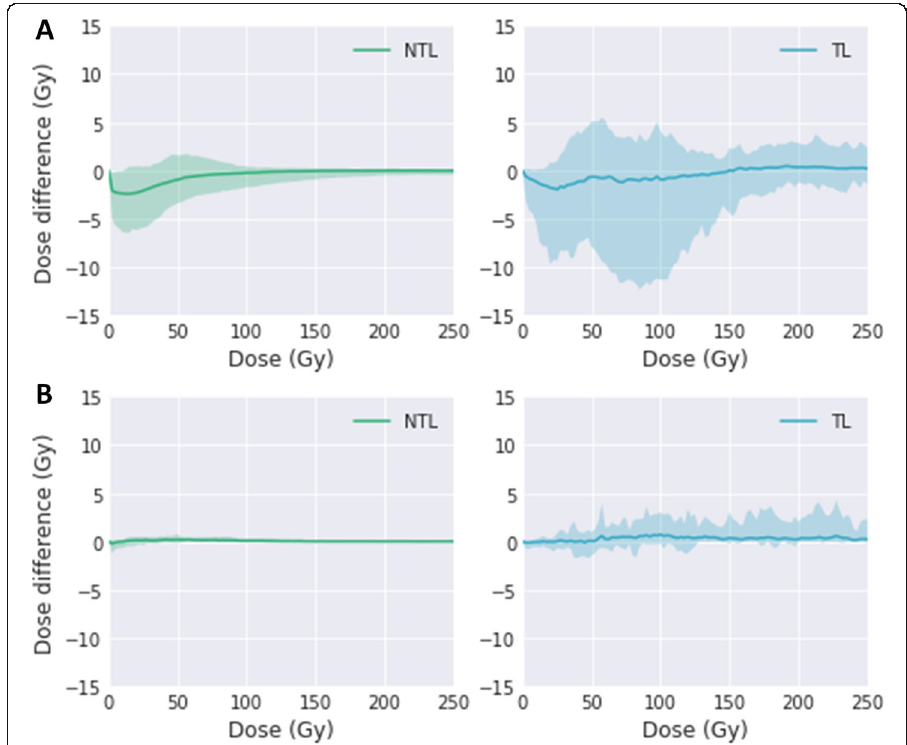
Fig. 6 The mean value (solid line) and associated 95% CI (shaded area) of dose differences before and after processing for NTL and TL. Dose differences were calculated as a function of dose bins (1 Gy/bin) ranging from 0 to 250 Gy. a Dose differences between original and deformed D Predicitve . b Dose differences